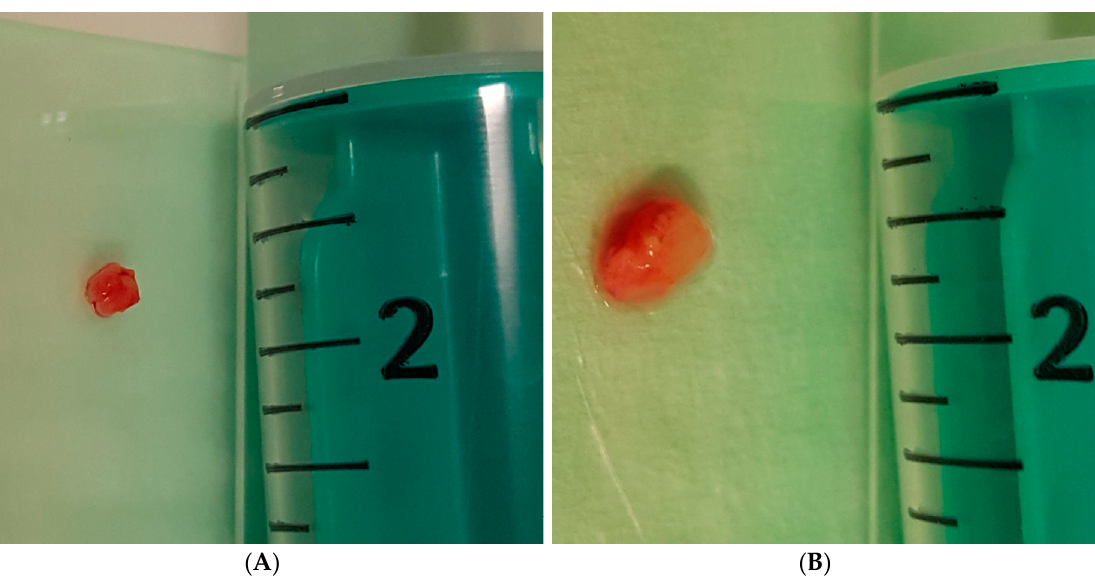
Figure 2. Examples of bronchoscopic forceps biopsy ( A ) and bronchoscopic cryobiopsy ( B ), as shown in two of the study patients.